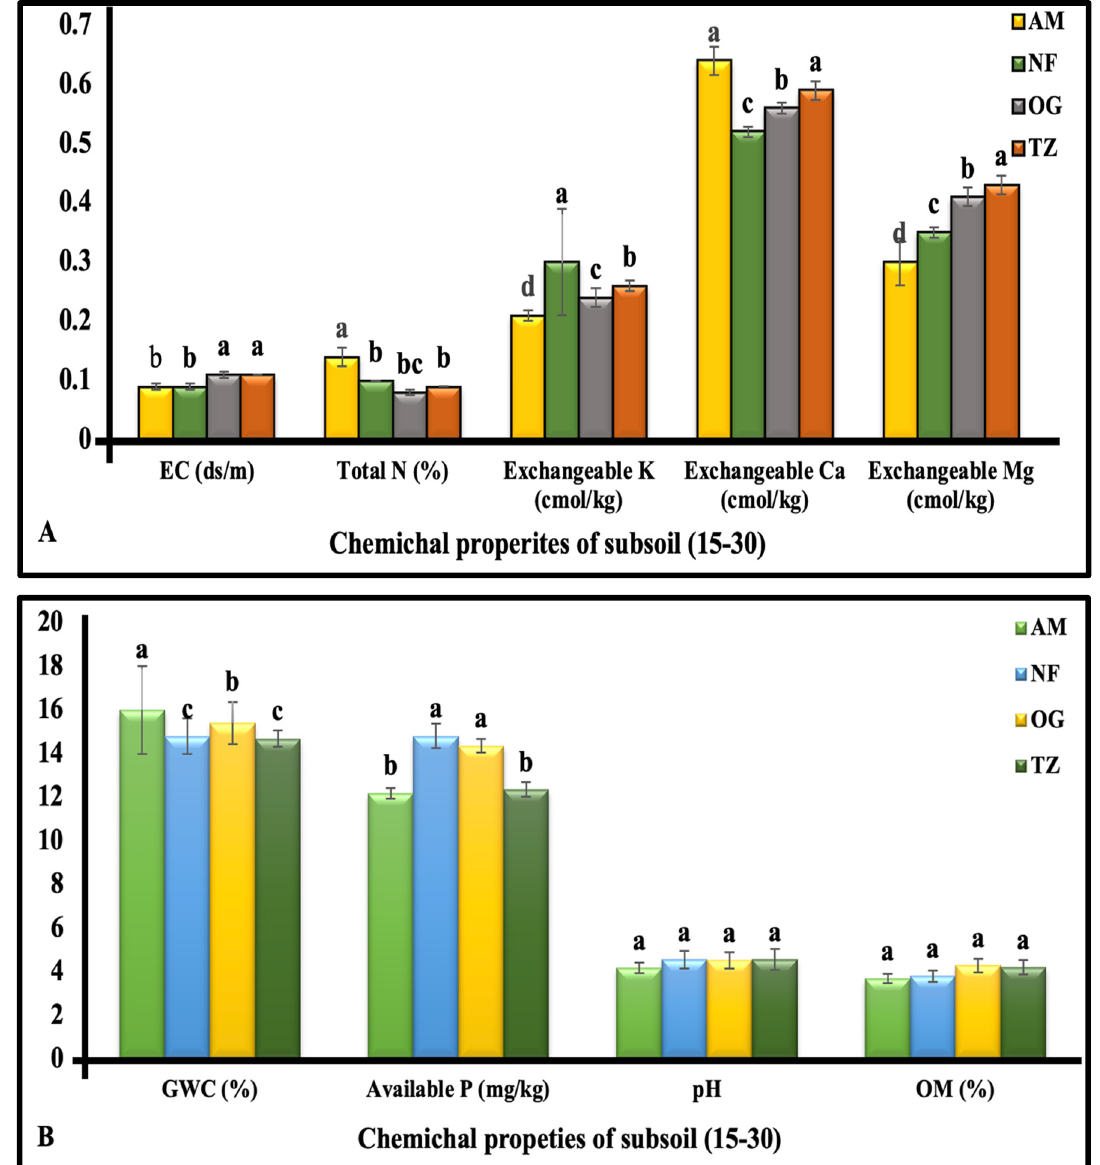
Figure 6. Measurements of ( A ) electrical conductivity (EC), total nitrogen (N), exchangeable calcium, exchangeable magnesium, and exchangeable potassium, and ( B ) gravitational water content, available phosphorus, pH, and organic matter of subsoil (15–30 cm depth) in Ayam Hiter forest of Malaysia across four different regions. Note: AM = Acacia mangium region, TZ = Transition region, OG = Open ground region, NF = Native Forest region. Distinct letters imply significant distinctions between arsenic concentrations following Duncan’s multiple comparison test ( p ≤ 0.01).